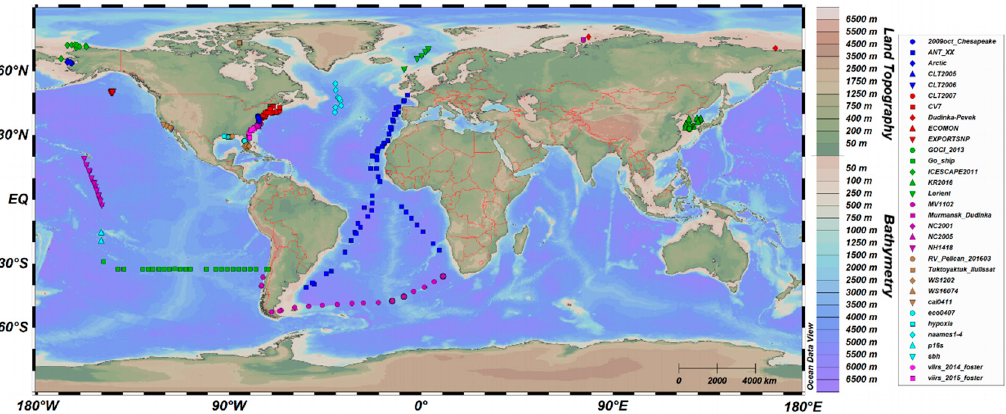
Figure 1. Locations of the 669 coincident in situ data with the cruise name displayed in the legend.